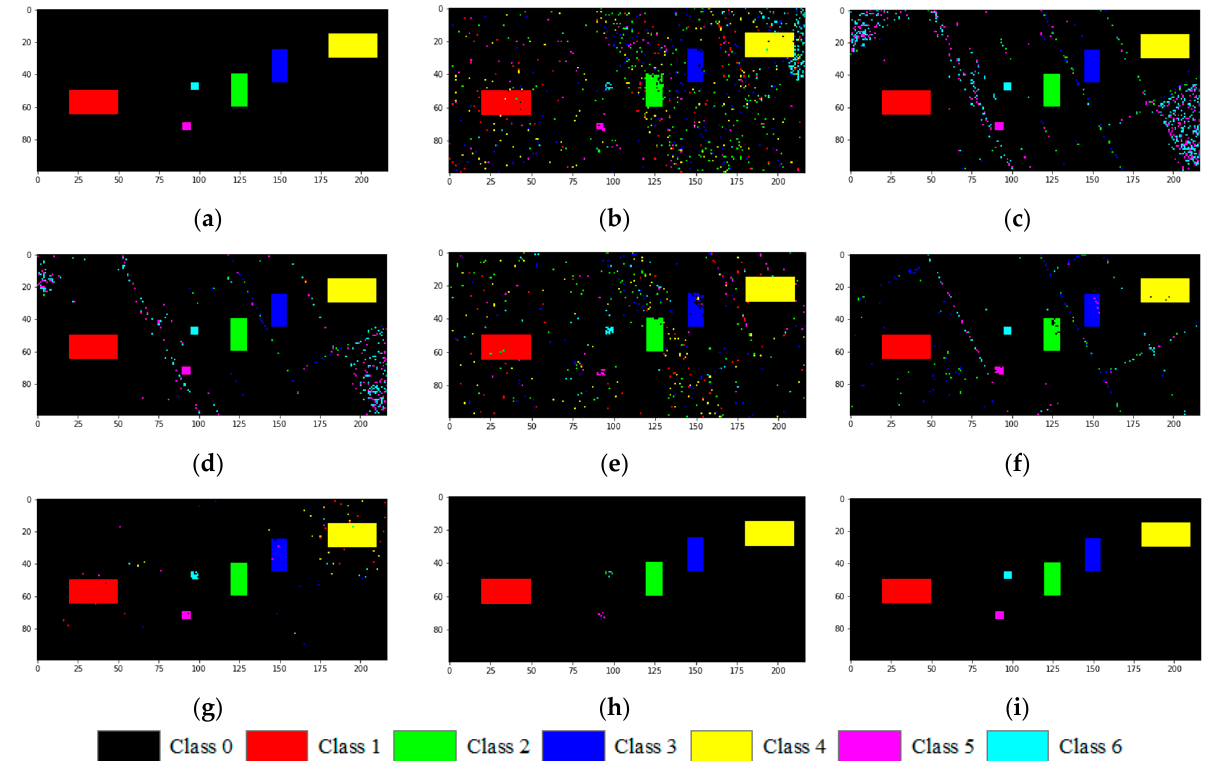
Figure 7. The experimental results of Simulated multitemporal image dataset: ( a ) reference image; ( b ) K-means; ( c ) RF; ( d ) SVM; ( e ) SU; ( f ) MSU; ( g ) MSUC; ( h ) SUJMC; and ( i ) MSUJMC.